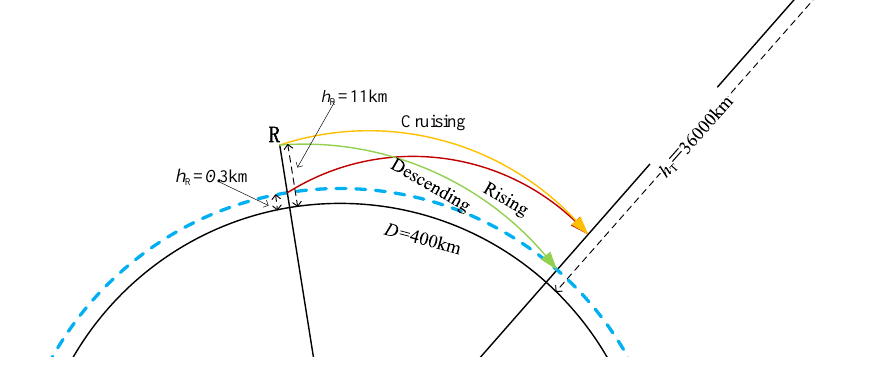
Figure 3. The Trajectories of the Aircraft Table 2. Simulation